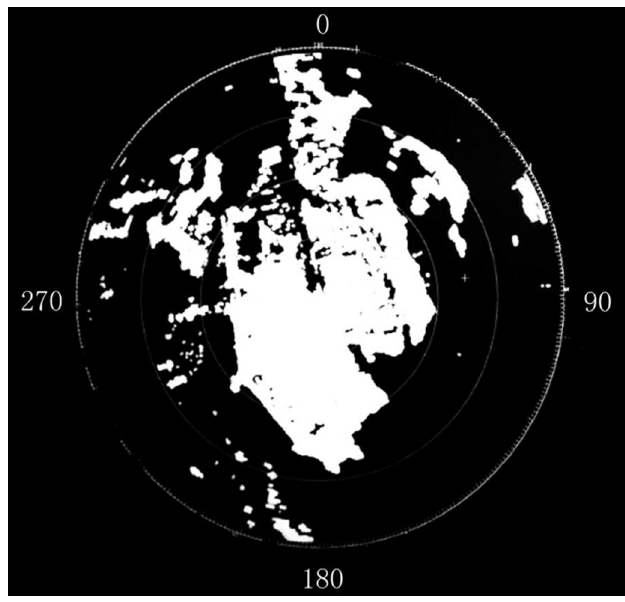
Fig. 5. Echo signal diagram before suppression.